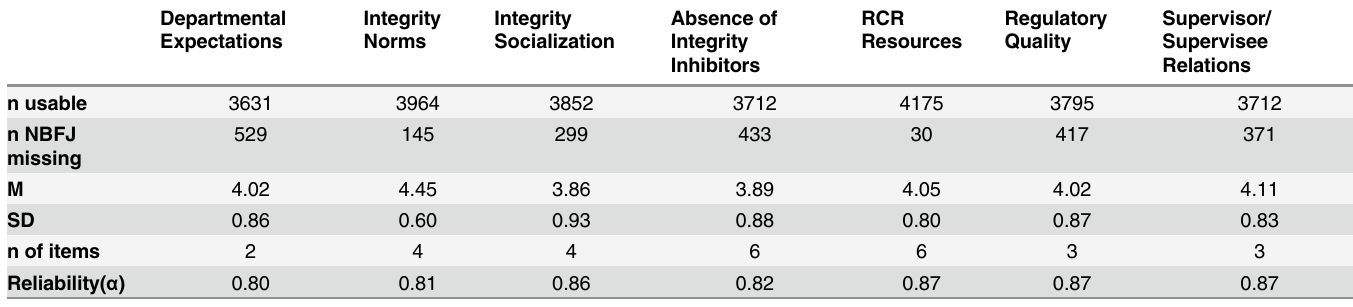
Table 1. Number of Cases, Means, Standard Deviations, and Reliability by Climate